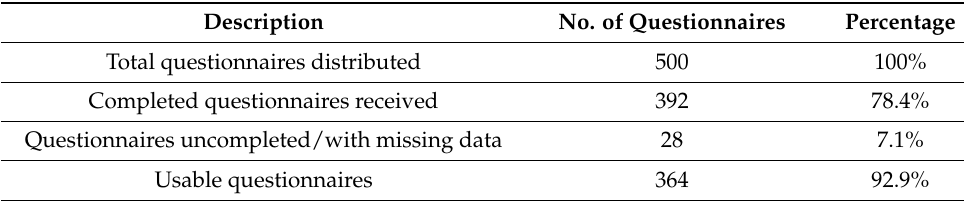
Table 1. The response rate of the data collected.